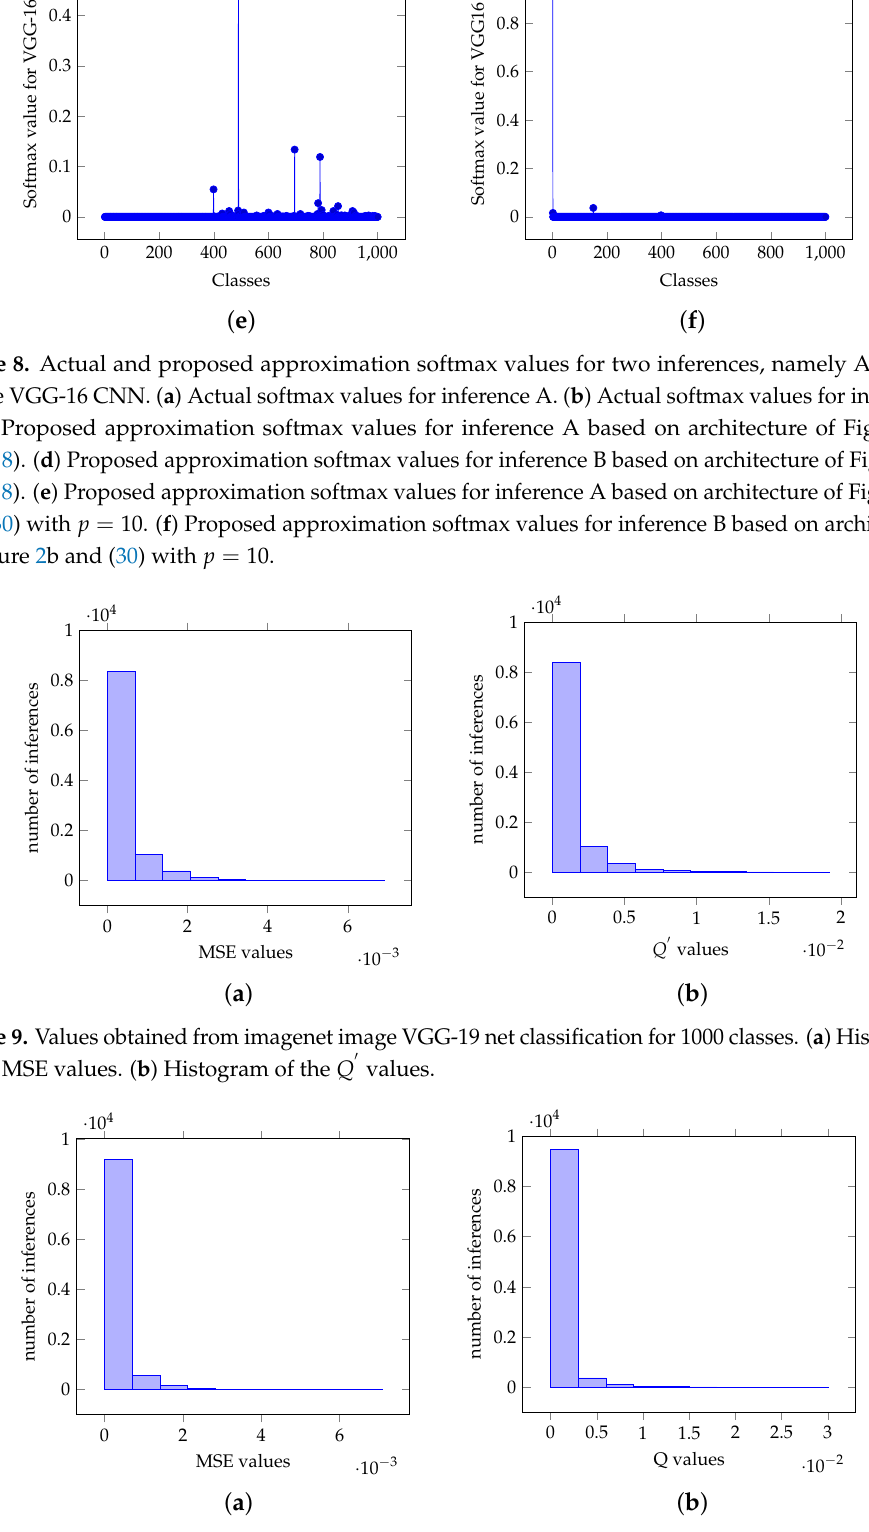
Figure 6. Values obtained from imagenet image ResNet-50 net classification for 1000 classes.